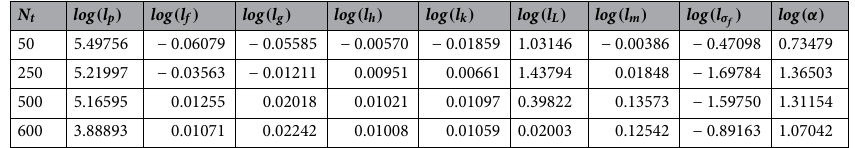
Table 3. Converged hyperparameters: N t time